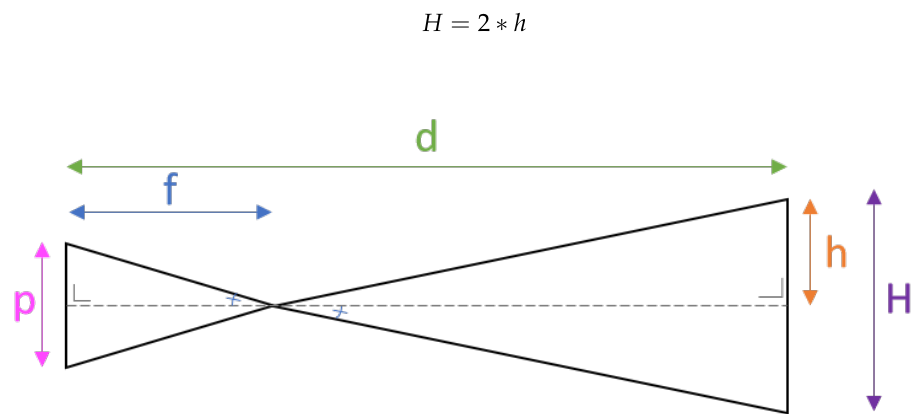
Figure 5. Schematic representation used to calculate the minimum defect diameter in order to be detectable for a certain camera height d . Using the detector pitch of the camera and the focal length of the lens the region recorded by one single pixel H can be